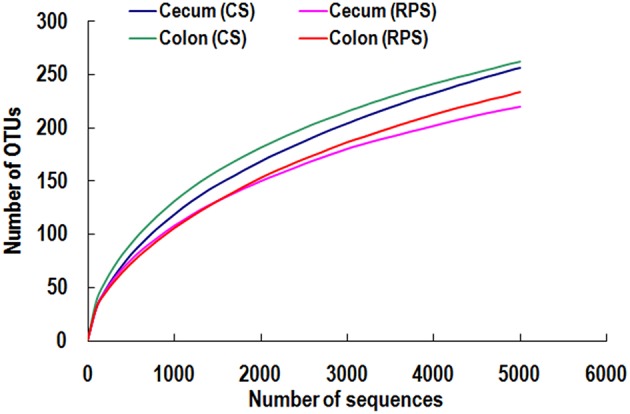
Rarefaction curves comparing the number of sequences with the number of OTUs found in the 16S rRNA gene libraries from microbiota in the cecum and colon of pigs in the corn starch (CS) and raw potato starch (RPS) groups.